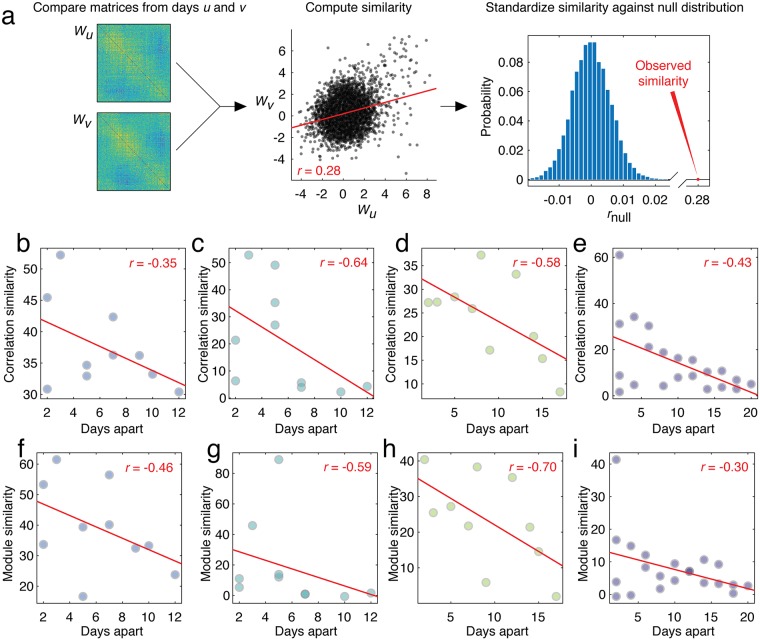
Reconfiguration of correlation structure over time.(a) Analysis pipeline for comparing correlation structure. For any two correlation matrices, Wu and Wv, whose elements have been z-scored against those obtained under a “jittered” null model in which random offsets were added to timeseries (see Methods), we vectorize the upper triangular elements and compute their similarity using a Pearson correlation coefficient. We compare the observed correlation coefficient against that which we would expect under a null model in which rows and columns of Wu are permuted uniformly at random. In panels (b), (c), (d), and (e), we show the scatterplots of standardized similarity scores for pairs of correlation matrices with the number of days separating their respective recording sessions. In panels (f), (g), (h), and (i), each point represents the standardized similarity scores of module co-assignment matrices across pairs of recording sessions.